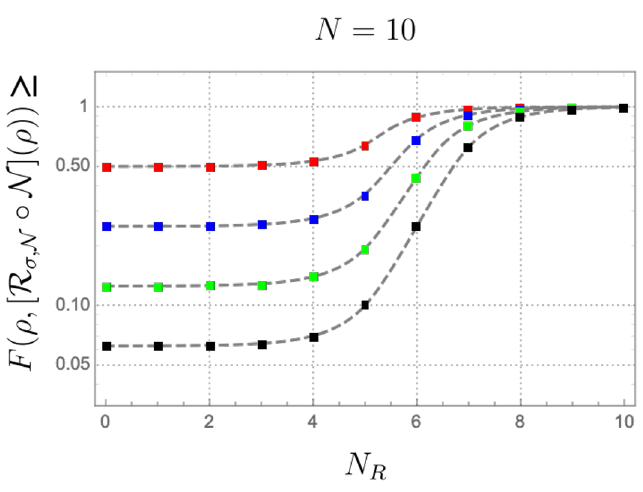
Figure 15 . The lower bound on the fidelity of the Petz map to recover the diary thrown into the black hole from the radiation as a function of the number of qubits N in the radiation, taking the R total number of qubits in the system to be N = 10 . The diary is composed of one (red), two (blue), three (green), or four (black) qubits. The dashed lines are the analytic predictions calculated at large N , (6.17), although the agreement is already very precise. In the numerical data, we take a fiducial pure state tensored with the diary state and apply a random unitary matrix, computing the relative entropy before and after the random channel. We take 10 3 disorder realizations. Error bars are plotted, though barely visible due to small